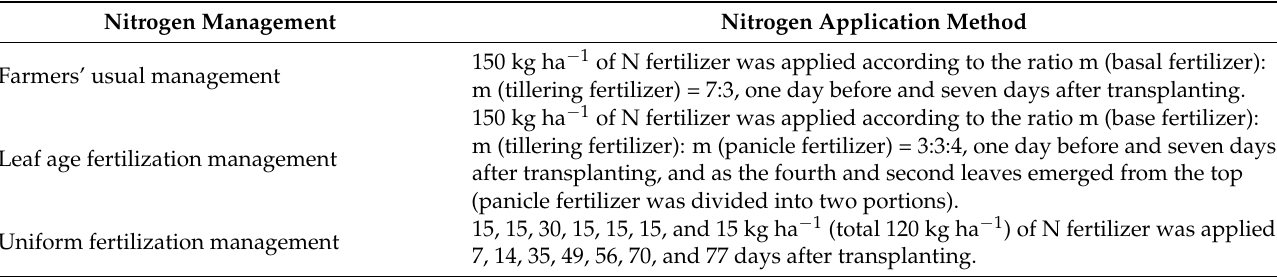
Table 3. Nitrogen management during the rice season in 2019 and